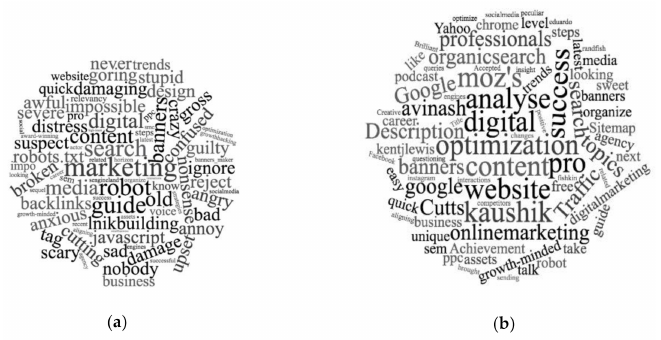
Figure 4. ( a ) Negative topics for SEO startups; ( b ) positive SEO topics for startups. Source: The